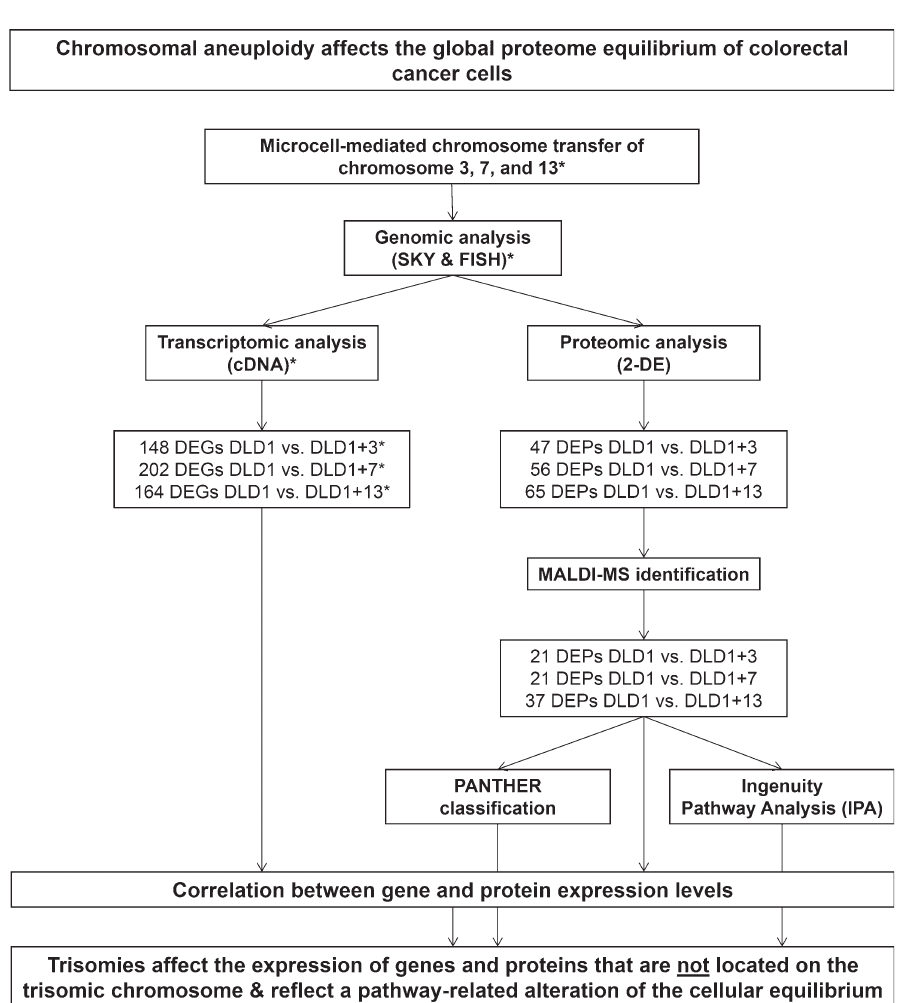
Fig. 1. Technical workflow of the study design for comperative proteomic analysis. *published by Upender et al. in 2004. SKY, Spectral karyotyping; FISH, Fluorescence in-situ hybridization; 2-DE, Two-dimensional gel electrophoresis; DEG, Differential expressed gene; DEP, Differential expressed